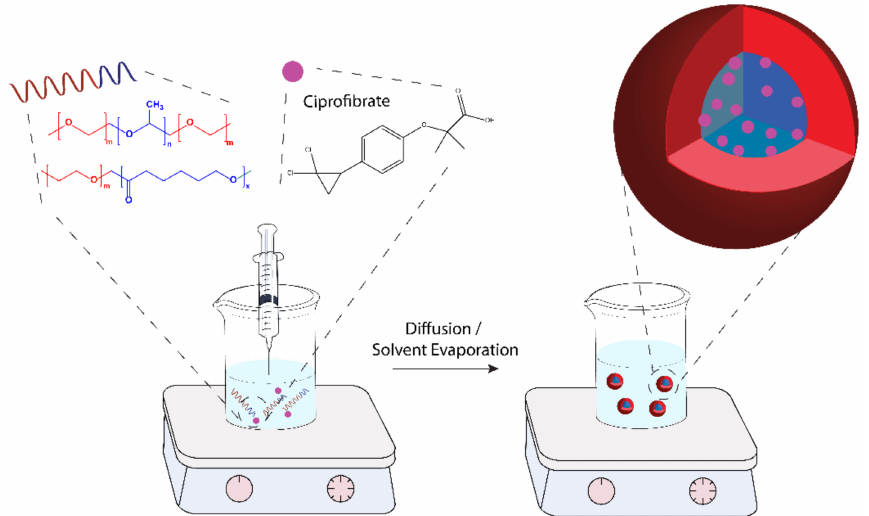
Figure 1. Scheme of preparation by nanoprecipitation of ciprofibrate-loaded